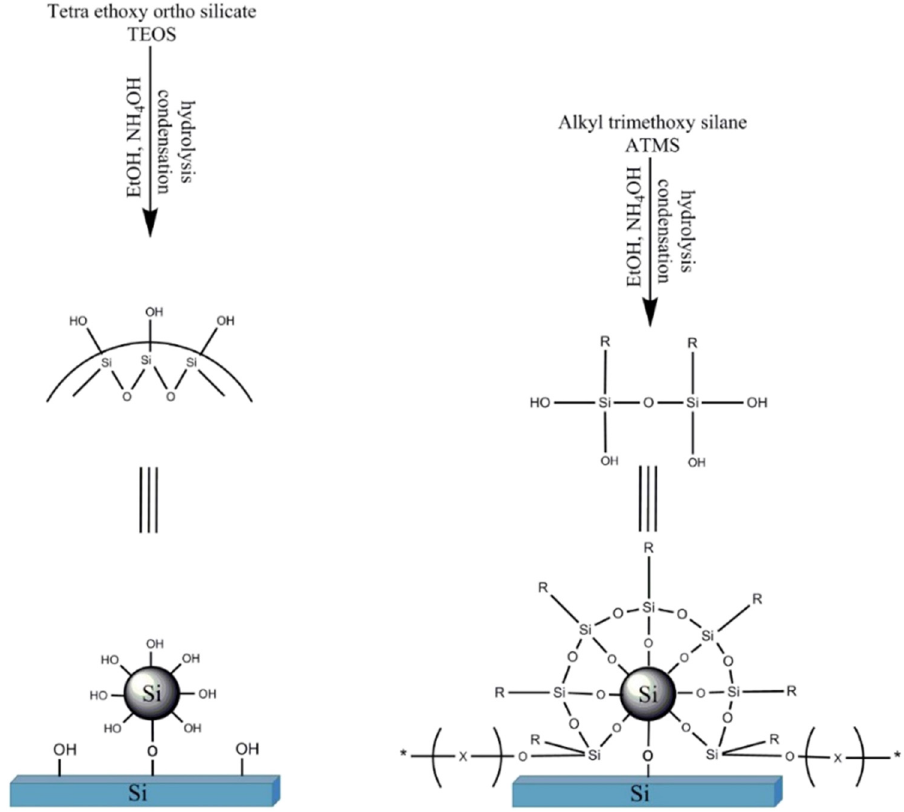
Figure 4: TEOS and ATMS hydrolysis condensation reaction process [ 57 ] ; Copyright: 2021 with permission from Elsevier